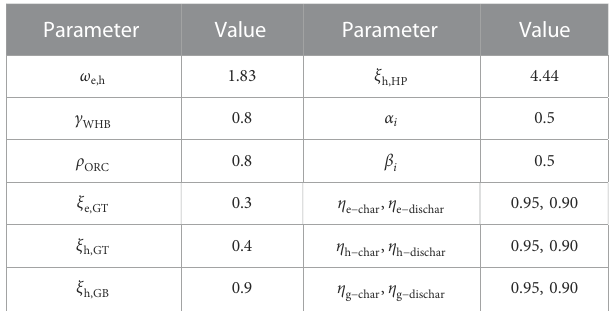
TABLE 2 Parameters of the IES.